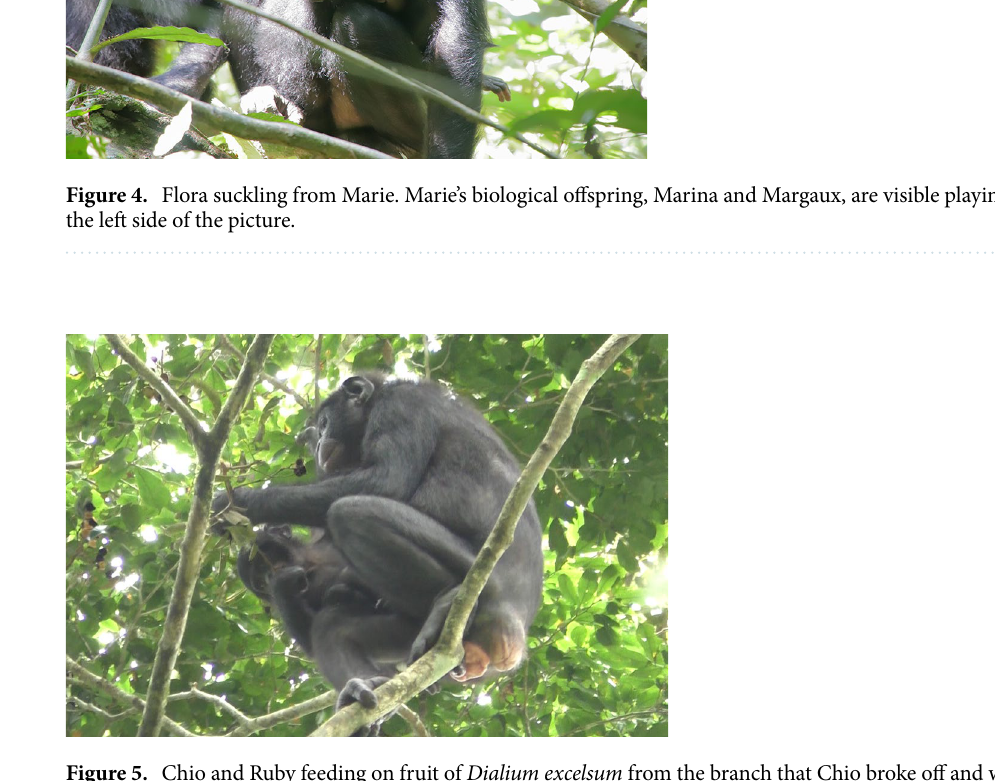
Figure 5. Chio and Ruby feeding on fruit of Dialium excelsum from the branch that Chio broke off and was